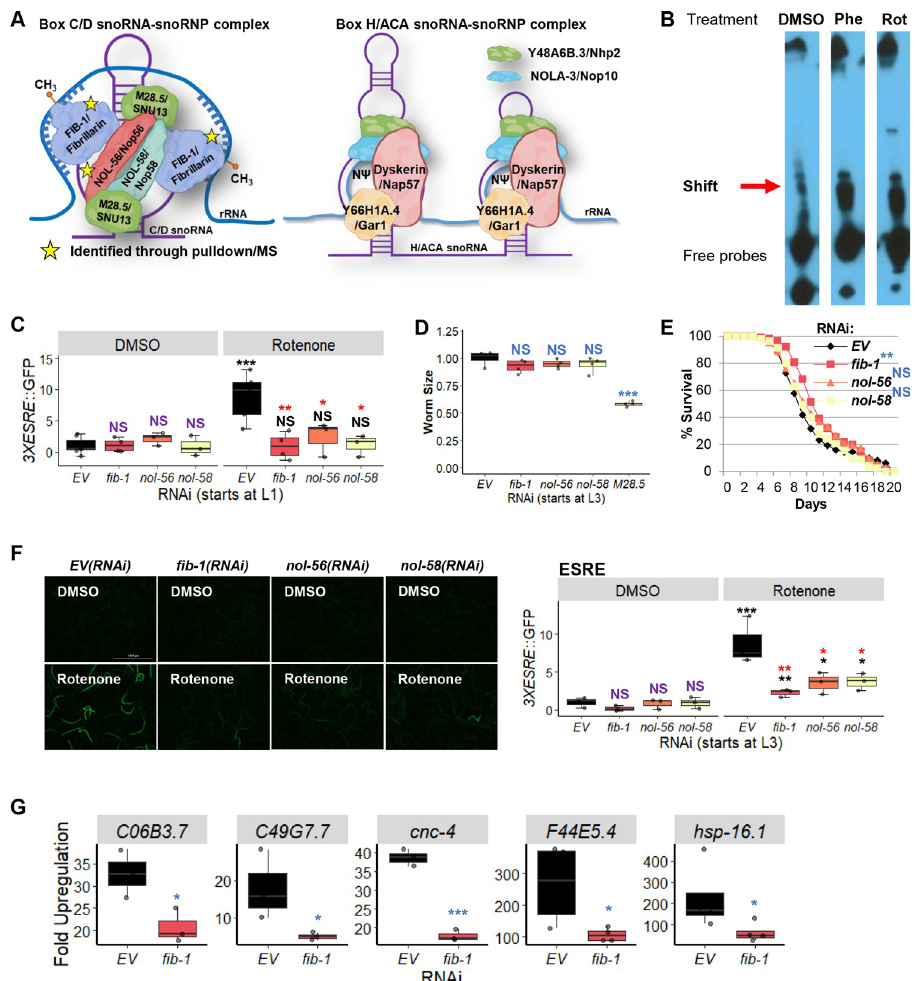
Fig 1. Box C/D snoRNP machinery binds to the ESRE motif. (A) Cartoon representation of box C/D ( left ) or box H/ ACA ( right ) snoRNA-snoRNP complexes. Stars indicate proteins identified through oligo pulldown-mass spectrometry. (B) Electrophoretic mobility shift assay (EMSA) showed the presence of the ESRE-binding motif through the identified ‘ Shift ’. (C) Quantification of GFP fluorescence of C . elegans carrying a 3XESRE ::GFP reporter that was reared on E . coli expressing RNAi targeting empty vector ( EV ) or fib-1(RNAi) , nol-56(RNAi) , or nol-58 (RNAi) . (D) The size and (E) lifespan of glp-4(bn2) worms grown on RNAi strains targeting Box C/D snoRNPs are shown. (F) Fluorescent images ( left ) and quantification of GFP fluorescence ( right ) of C . elegans carrying a 3XESRE :: GFP reporter reared on E . coli expressing RNAi targeting empty vector ( EV ), fib-1(RNAi) , nol-56(RNAi) , or nol-58 (RNAi) . (G) Upregulation of ESRE gene transcripts as measured via qRT-PCR. Worms were reared on E . coli expressing RNAi targeting empty vector (EV) or fib-1(RNAi) and were treated with DMSO or 25 μ M rotenone for 8 hours. RNAi treatment was started at the L1 (C) or L3 (D-G) stage. Representative images are shown. Three biological replicates comprised of ~400 (C, D, F) , ~150 (E) , or ~8,000 (G) worms/replicate were analyzed. A representative replicate for the lifespan assay is shown (E) . (C, F) Worms were treated for 8 hours with vehicle (DMSO) or 50 μ M rotenone and GFP values were normalized to EV -DMSO. Worms’ sizes were normalized to EV control. p values were determined from two-way or one-way ANOVA for ESRE expression and worms’ size measurement, respectively, followed by Dunnett’s test, log-rank test for lifespan assay, or Student’s t- test for qRT-PCR. NS not significant, � p < 0.05, �� p < 0.01, ��� p < 0.001. In panels with colored significance marks, purple indicates comparison between gene(RNAi) and EV(RNAi) in control condition (DMSO), red indicates comparison between gene(RNAi) and EV (RNAi) in stressed condition (rotenone), and black indicates comparison between stressed and control conditions. https://doi.org/10.1371/journal.pgen.1010103.g001 We detected multiple bands from the EMSA, labeled as ‘ Shift ’ and ‘Free probes’ ( Fig 1B ). The ‘Free probes’ are excess biotinylated ESRE oligos that did not bind protein. Multiple ‘ Shift ‘ bands were observed, which may indicate constitutive binding of the ESRE motif or a